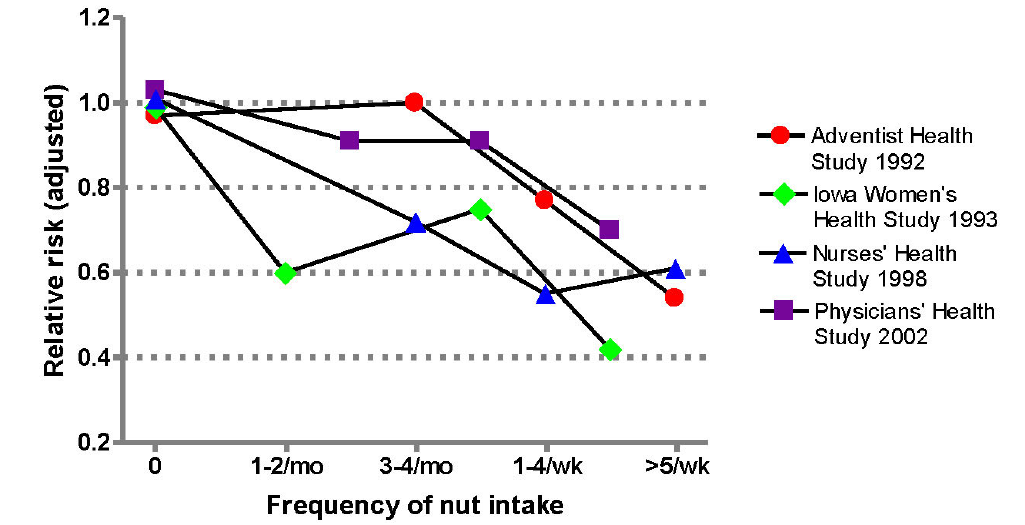
Figure 1 . Results of prospective studies of nut consumption and risk of death from coronary heart